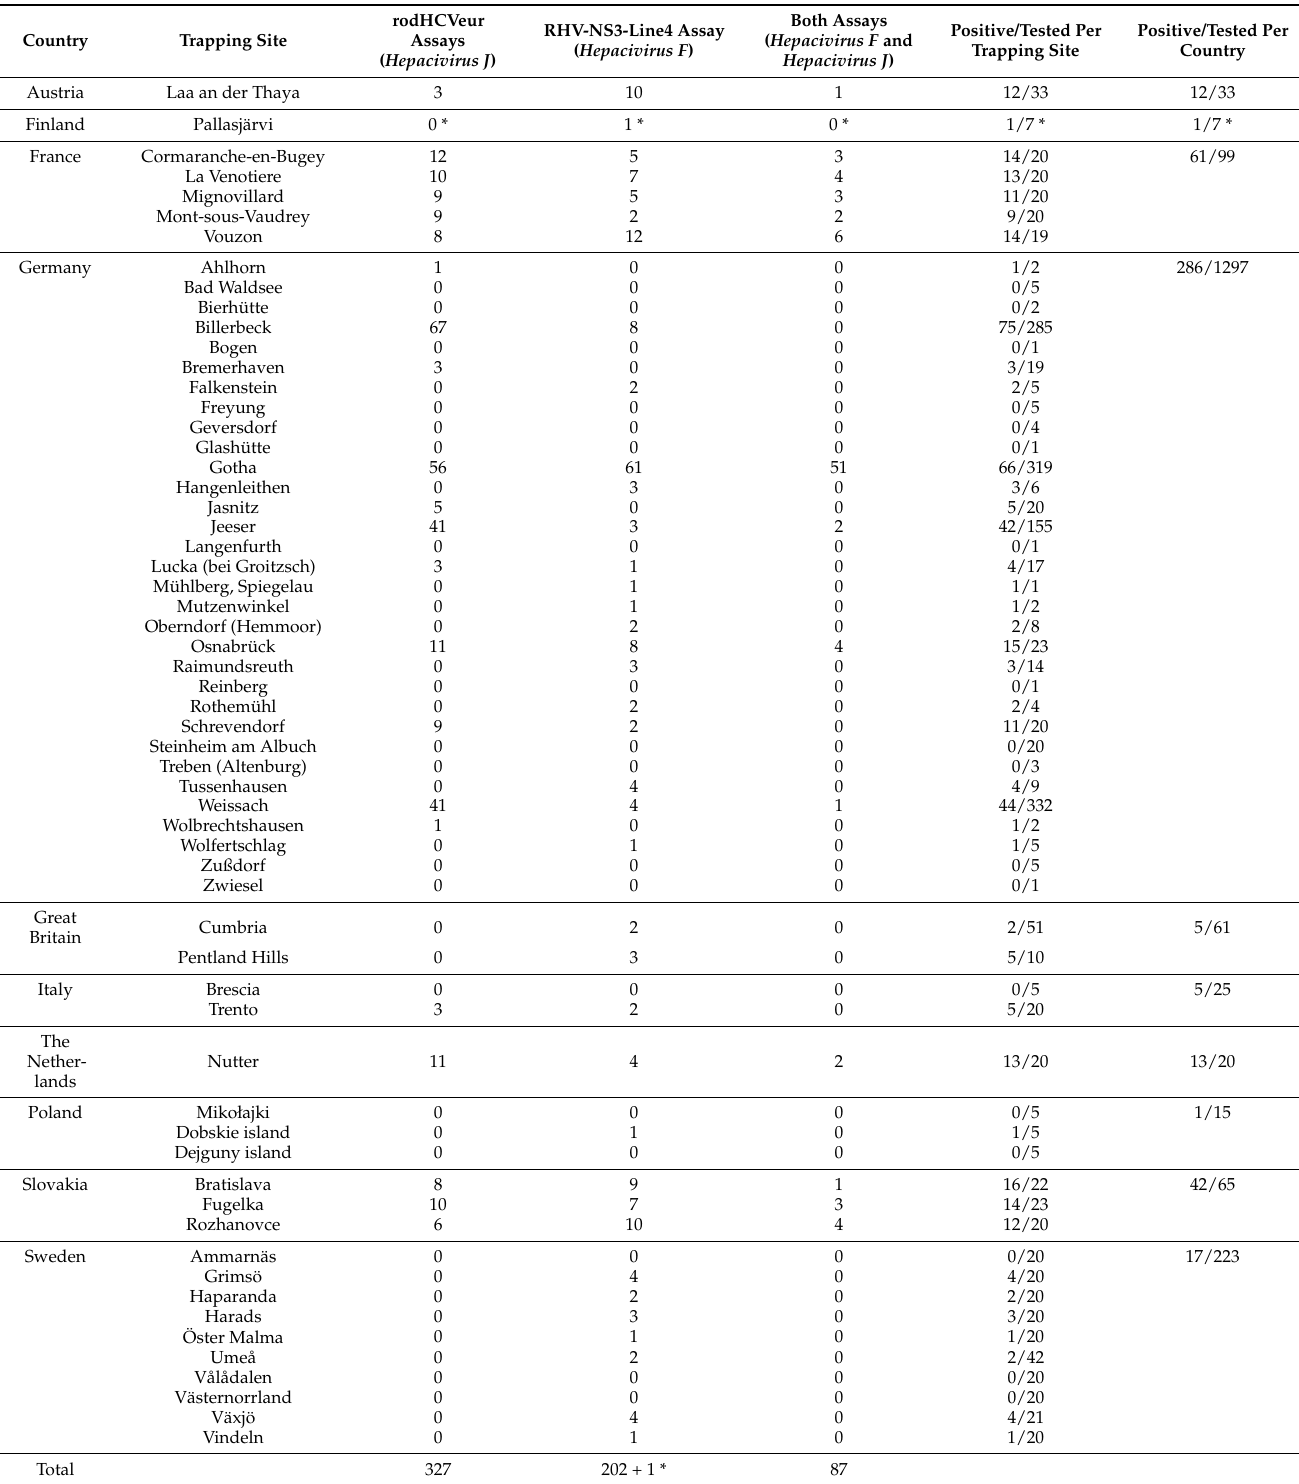
Table 2. Results of RT-qPCR assays of bank voles and northern red-backed voles (*) at country and trapping site level. All samples were tested in both